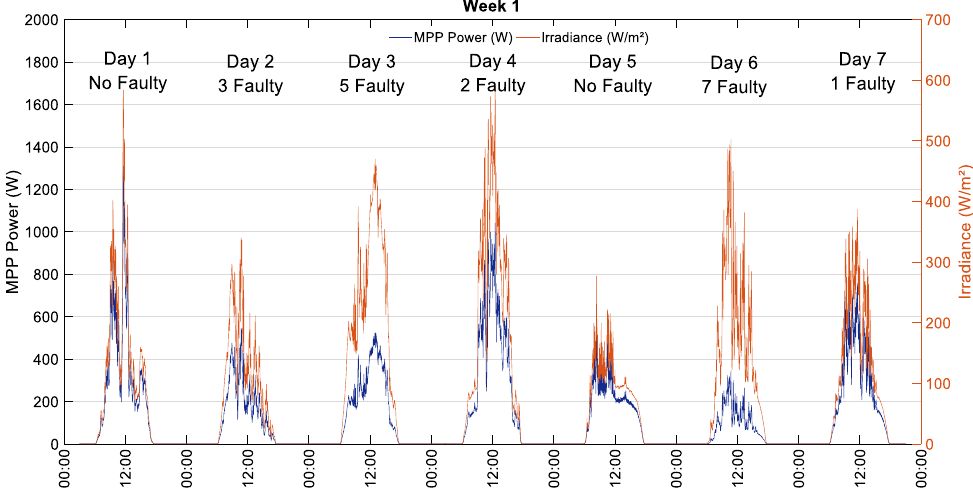
Figure 13. System 1 experimental results on week 1 for irradiance G and P MPP.